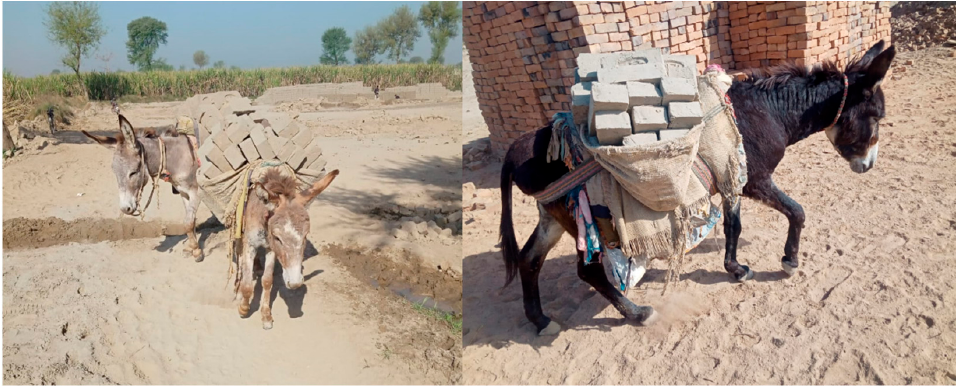
Figure 3. Brick kiln donkeys involved in the transportation of bricks in southern Punjab, Pakistan. Photo: Syed Saad Ul Hassan Bukhari.